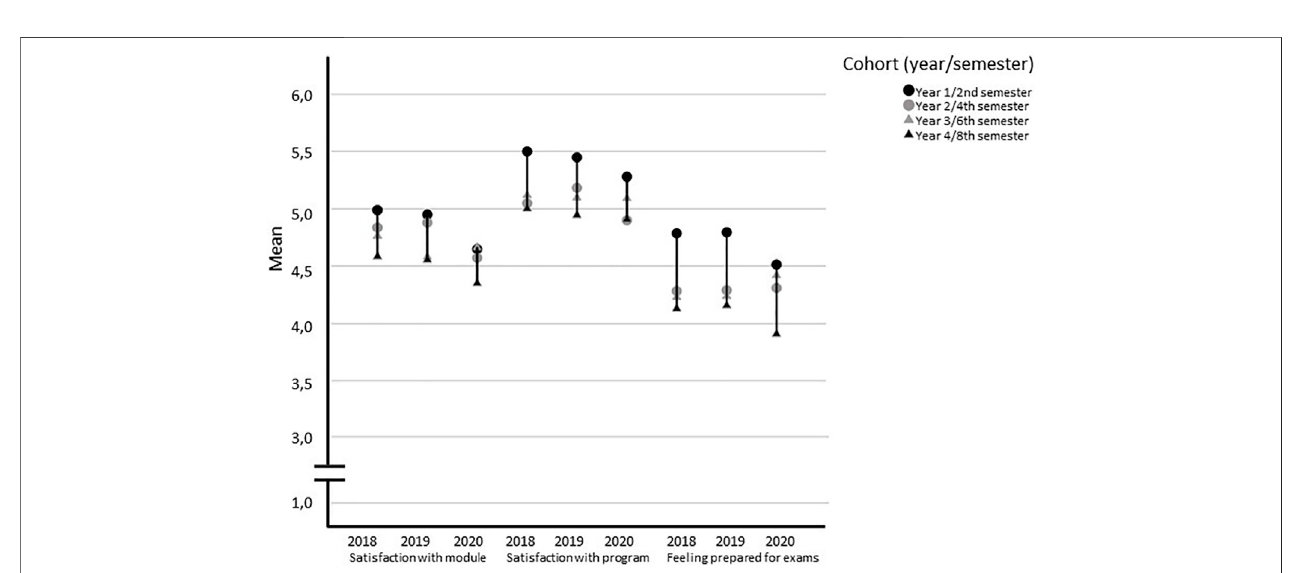
FIGURE 3 | Drop-line chart showing the difference of satisfaction and feeling of preparedness for exams between four cohorts.